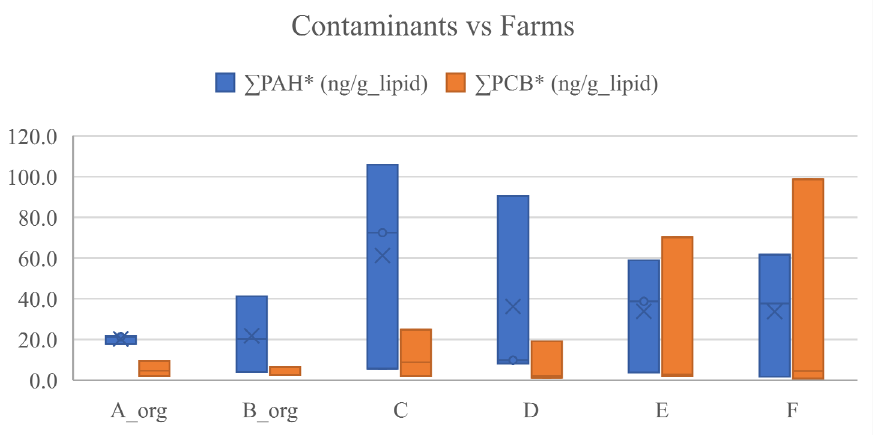
Figure 2. Box plot of contaminants in cheese samples versus farms. The * symbols refer to the values normalized per gram lipid amount.